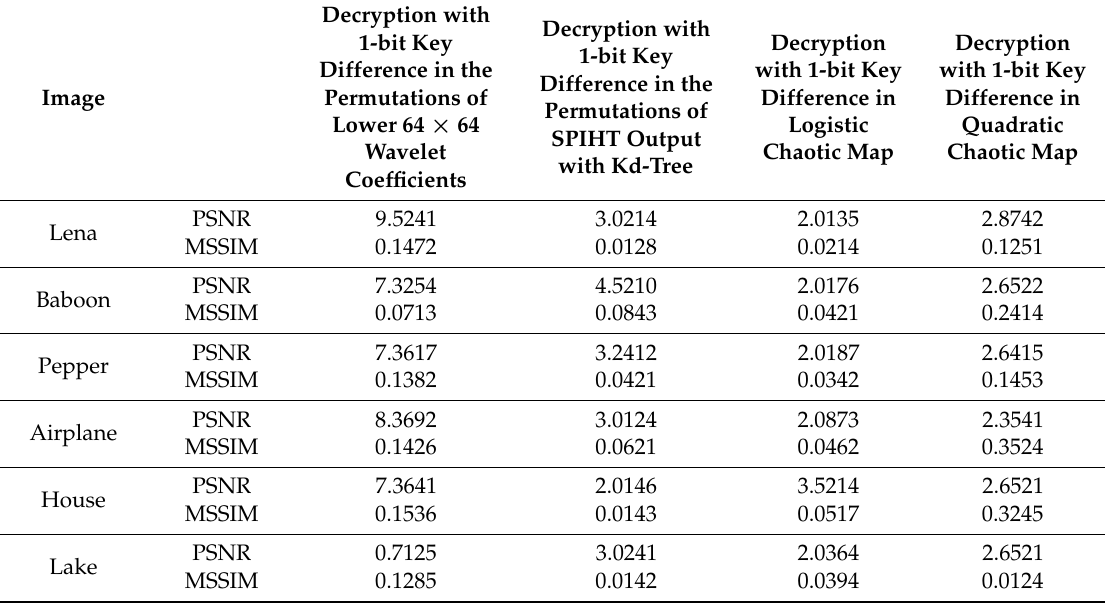
Table 3. PSNR and MSSIM of the decrypted image with wrong